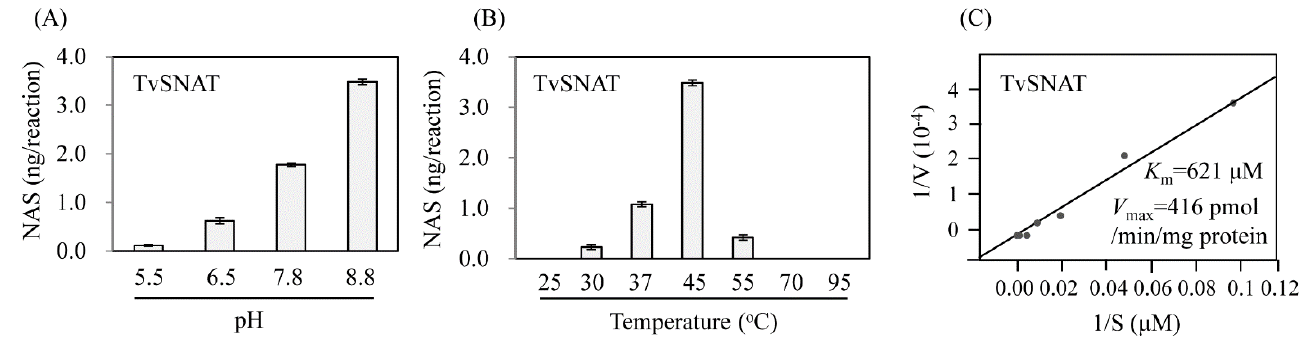
Figure 2. SNAT enzyme activity catalyzing the conversion of serotonin to N -acetylserotonin as a function of ( A ) pH and ( B ) temperature. ( C ) Determination of substrate affinity ( K m ) and maximum reaction rate ( V max ) values of TvSNAT (also called TvArd1). TvSNAT (1 μg) was incubated at a range of pH values and temperatures for 30 min. K m and V max values were determined using Lineweaver– Burk plots. In vitro enzymatic N -acetylserotonin products were measured by high-performance liquid chromatography. Data are the means ± standard deviation ( n = 3).